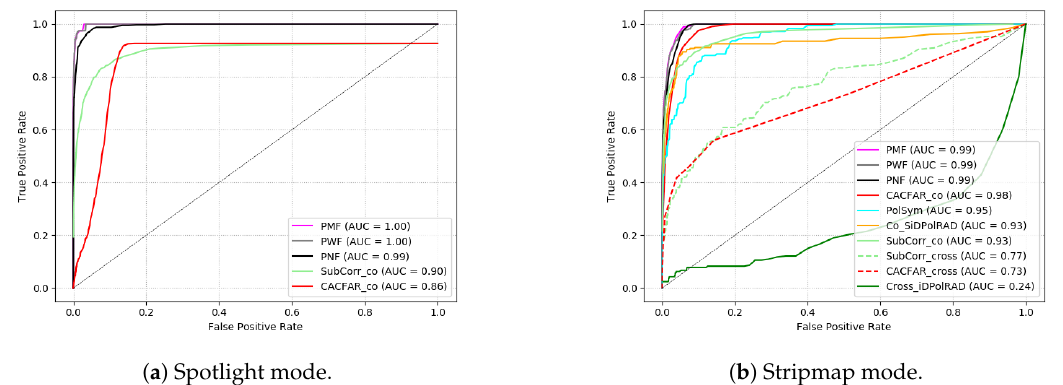
Figure 9. Assessing multilooking: ROC curves for different TSX-modes (pixel-based, not multilooked).